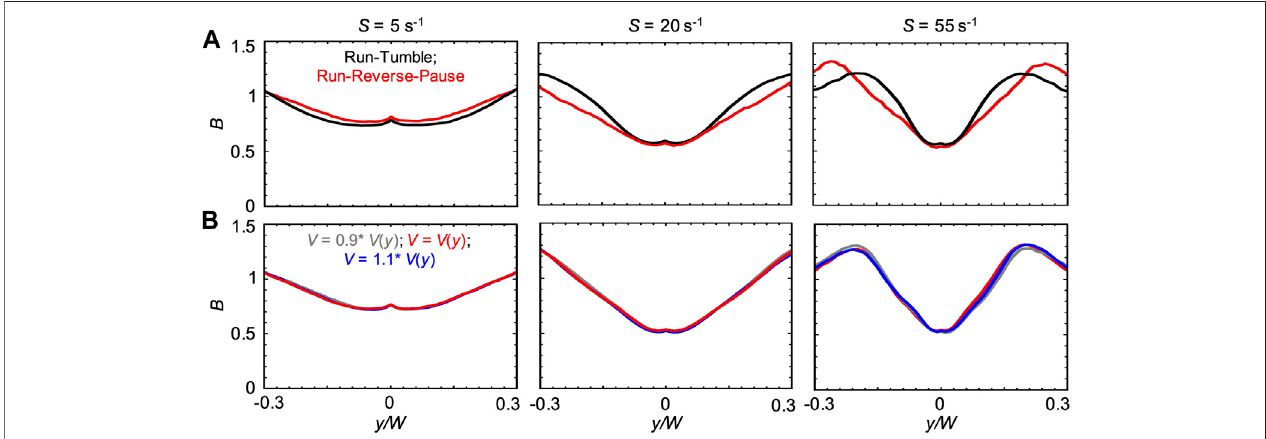
FIGURE 9 | (A) Bacterial concentration pro fi les B numerically calculated according to the mathematical model for mean shear rates S = 5 s − 1 (left), S = 20 s − 1 (center)and S =55s − 1 (right)inxanthangum0.1w/v%,atadistance D =50 cmforswimmerswithrun-tumble(black)andrun-reverse-pause(red)patterns.Fortherun- tumbleswimmersweused q =9.4, V =29.4, μ ms − 1 ,and D R =1.4 rad 2 s − 1 asin[29],whiletherun-reverse-pauseswimmersweresimulatedwithswimmingvelocity V ( y ), as described in the Materials and Methods. (B) Bacterial concentration pro fi les B calculated according to the mathematical model for mean shear rates S = 5 s − 1 (left), S =20 s − 1 (center)and S =55 s − 1 (right)inxanthangumat0.1w/v%,forrun-reverse-pauseswimmerswithswimmingvelocitiesof V ( y ),calculatedaccordingto Eq. 5 (red), V = 0.9 V ( y ) (grey) and V = 1.1 V ( y )